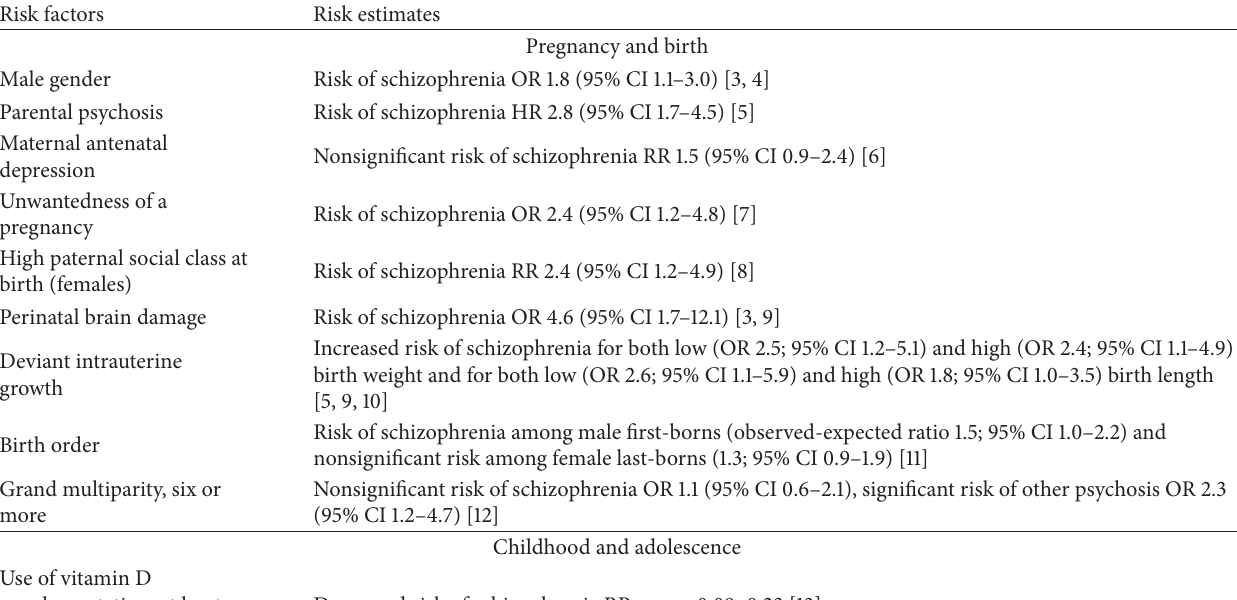
Table 1: Risk factors of schizophrenia in the Northern Finland Birth Cohort